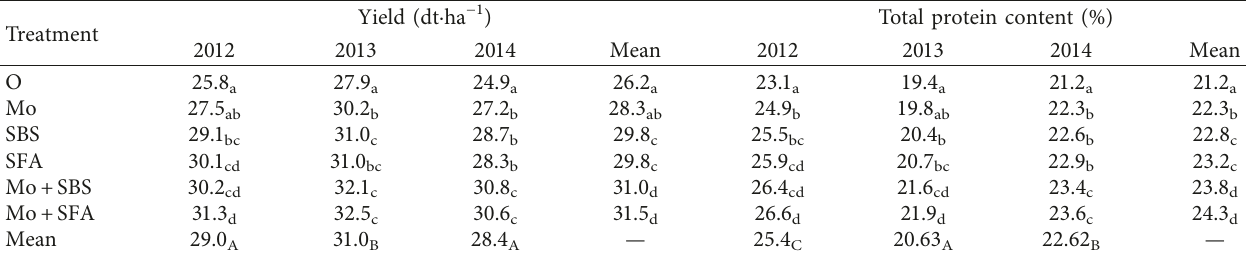
Table 1: The influence of Mo and S application on the seeds yield and total protein content.